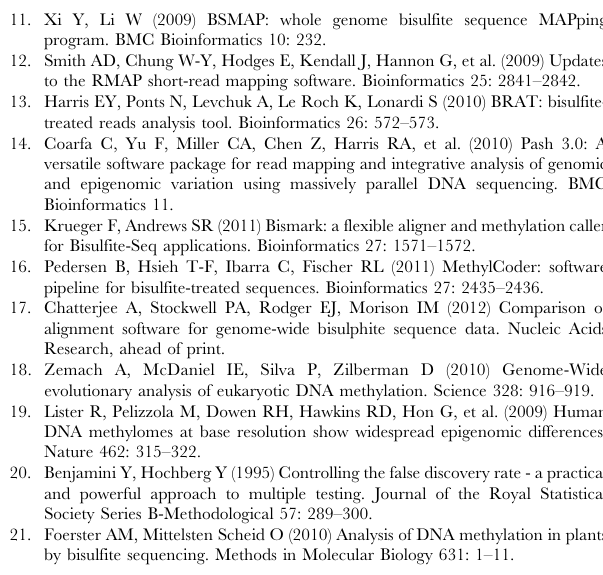
Table S14 Characteristics of validated regions (M/X category). (XLS) Table S15 Characteristics of validated regions (M/X category). Table S16 Characteristics of validated regions (M/X category). (XLS) Table S17 Characteristics of validated regions (M/X category). (XLS) Table S18 Characteristics of validated regions (M/X category). Table S19 Characteristics of validated regions (M/X category). (XLS) Table S20 Characteristics of validated region with underestimated methylation.